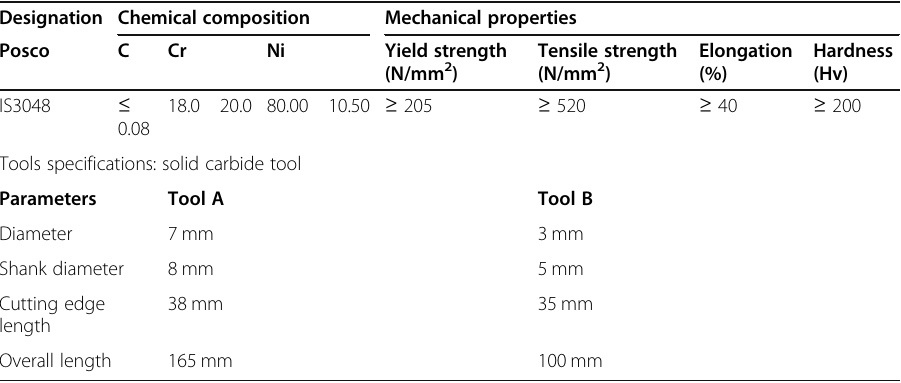
Table 1 Chemical composition and mechanical properties of IS3048 workpiece (IS:3048-1965: UDC 621-514.59 Indian Standard Dimensions for Handwheels)